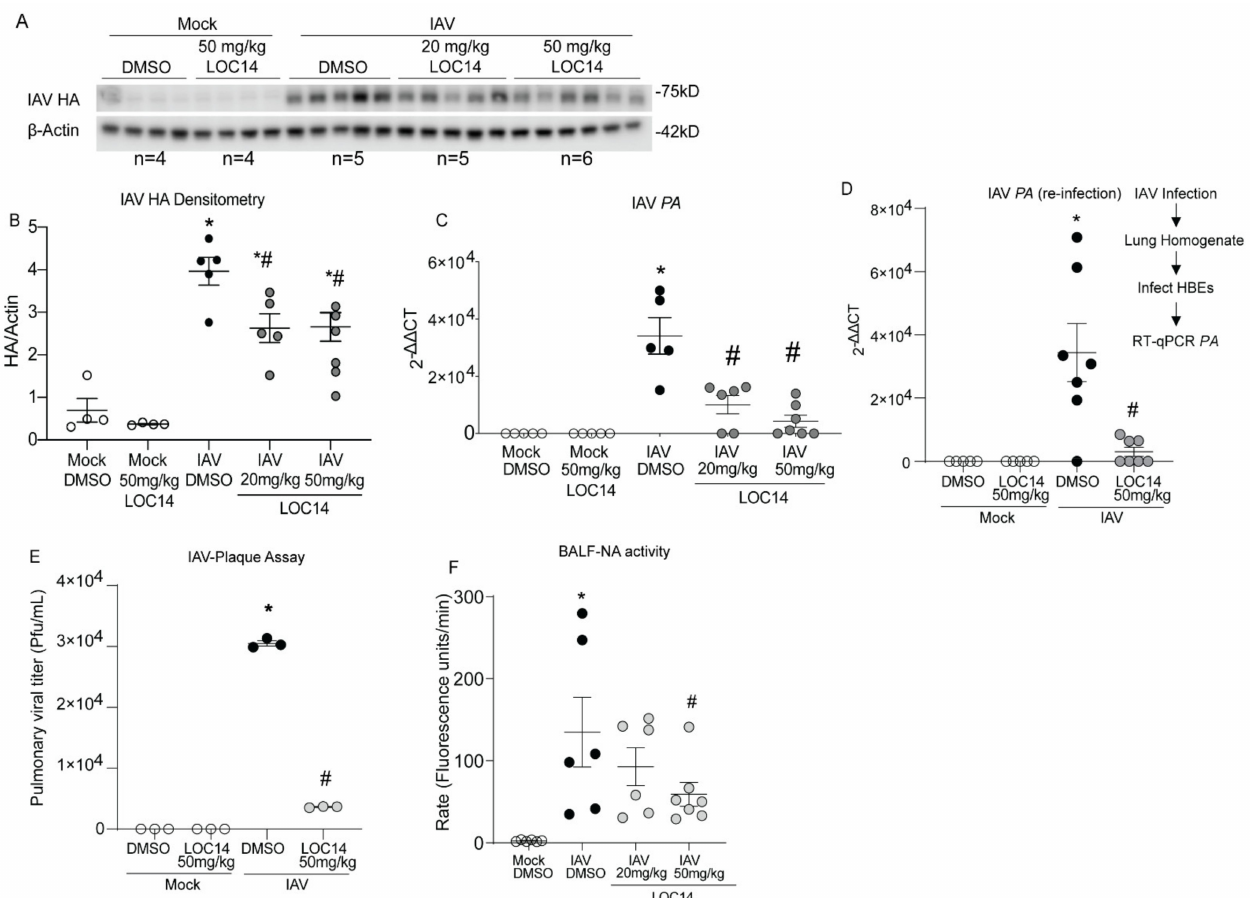
Figure 4. LOC14 treatment decreases the influenza burden in mice. ( A , B ). Western blot analysis of IAV HA and densitometry of HA normalized to actin. ( C , D ) Analysis mRNA for influenza PA in whole lung lysate by RT-qPCR and analysis mRNA by RT-qPCR for influenza PA from the lung homogenate re-infected into HBE. ( E ) IAV plaque formation assay. ( F ) Analysis of NA activity in the BALF. * p < 0.05 compared to mock groups, # p < 0.05 compared to IAV-DMSO group by two-way ANOVA. Data are expressed as the standard error of the mean ( ±